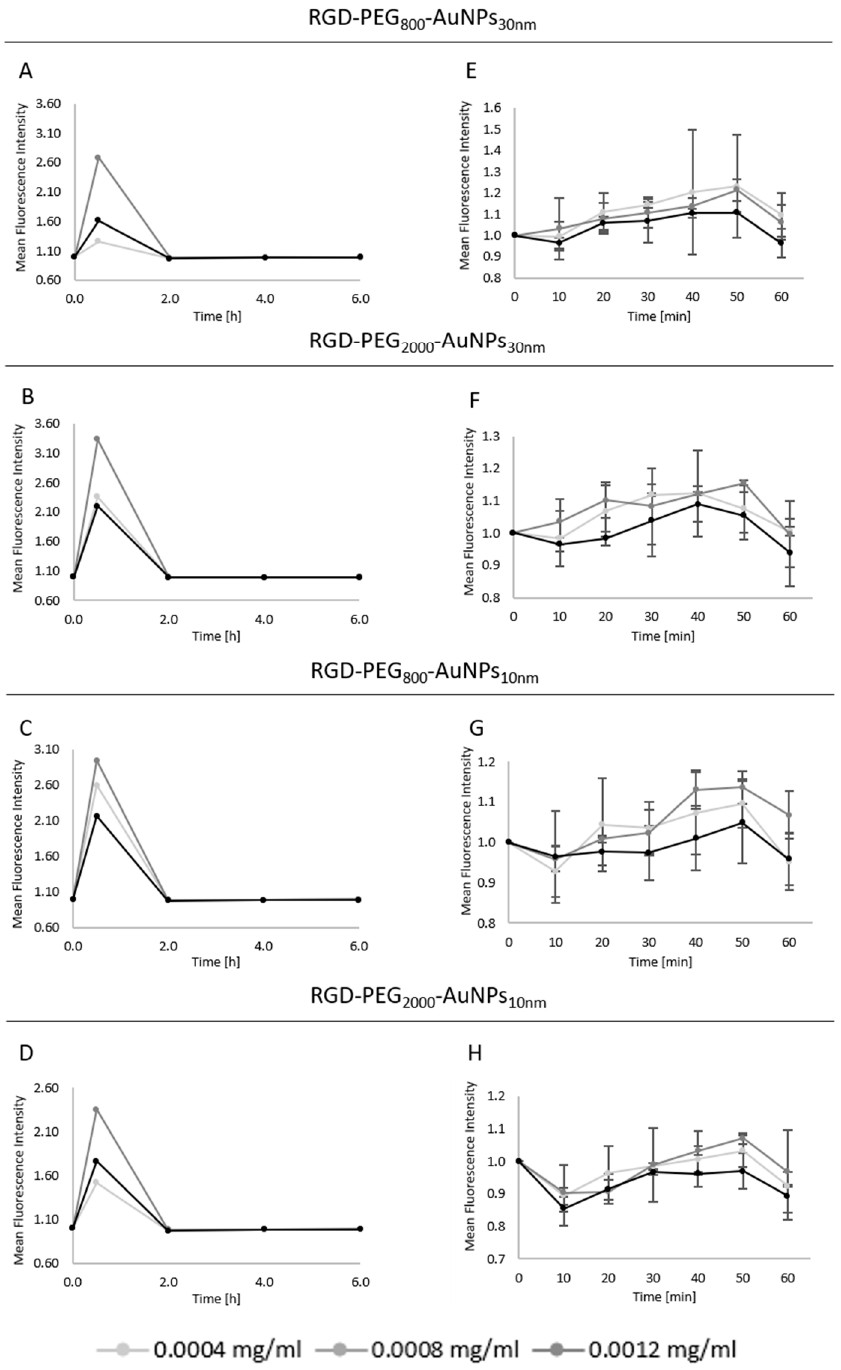
Figure 5. The ROS induction—optimization of the incubation time and AuNP concentration. The preliminary experiments were performed to optimize the TPs of the highest level of ROS generation. The experiment was performed singly ats TP of 30 min, 2, 4, and 6 h incubation with RGD-PEG 800 - AuNPs 10nm ( A ), RGD-PEG 2000 -AuNPs 10nm ( B ), RGD-PEG 800 -AuNPs 30nm ( C ). and RGD-PEG 2000 - AuNPs 30nm ( D ). The range of 1 h was investigated; thus, the ROS level was checked every 10 min using RGD-PEG 800 -AuNPs 10nm ( E ), RGD-PEG 2000 -AuNPs 10nm ( F ), RGD-PEG 800 -AuNPs 30nm ( G ), and RGD-PEG 2000 -AuNPs 30nm ( H ).